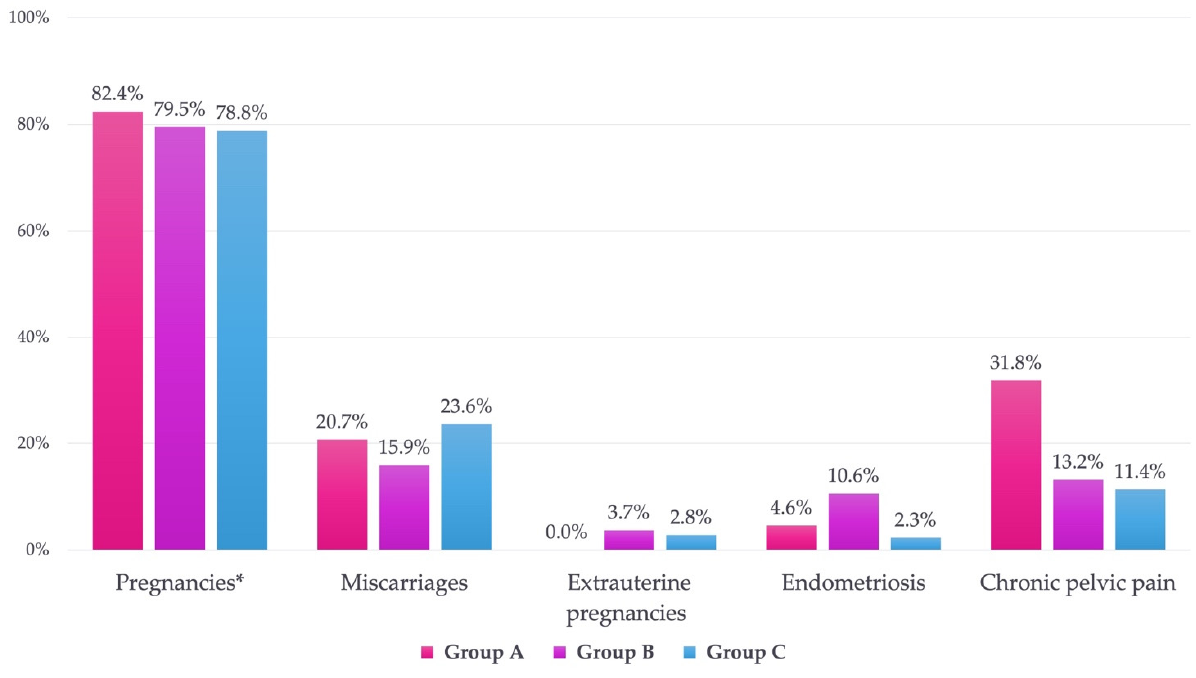
Figure 2. Incidence of pregnancies, miscarriages, ectopic pregnancies, endometriosis, and chronic pelvic pain in the three groups. Group A: complicated AA, Group B: not-complicated AA, Group C: control group; *: pregnancies in women in a stable relationship. Table 1. Data of the study and p -values. Group A: complicated AA, Group B: not-complicated AA, Group C: control group; *: pregnancies in women in a stable relationship.